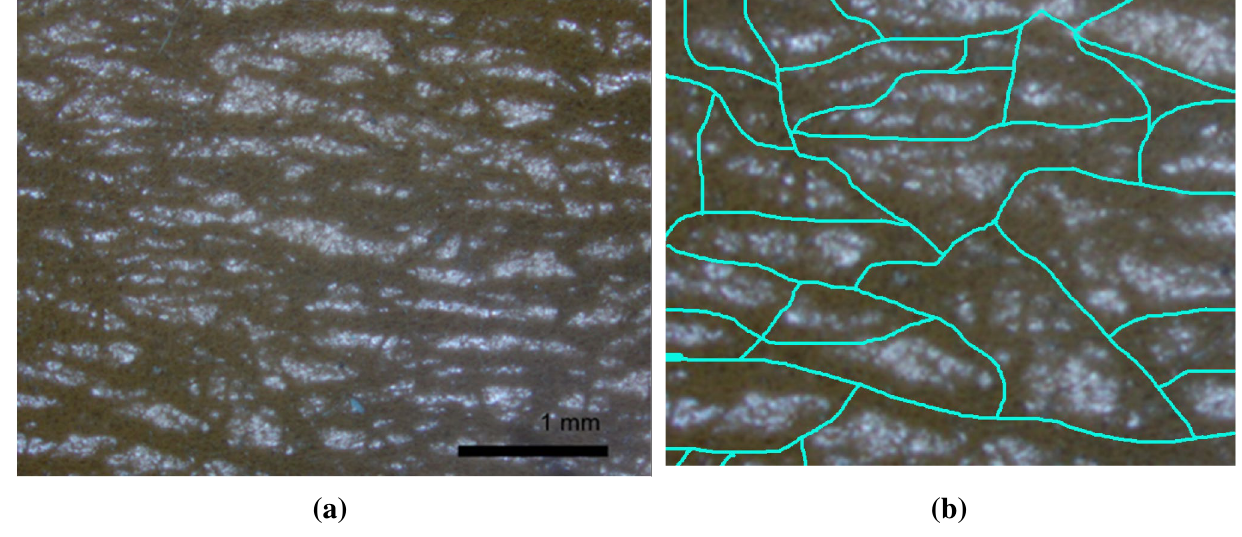
Fig. 9 Interior structure of MAE forming in a magnetic field at a medium filler concentration (20 wt%) ( a ). Formation of possible electrically conductive channels ( b